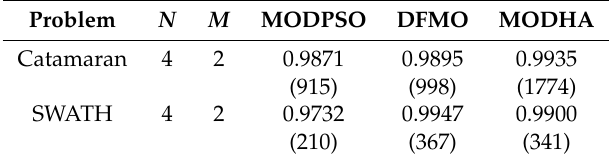
Figure 10. SBDO problems: Comparison of the non-dominated solution sets obtained (from left to right) by MODPSO, DFMO, and MODHA with the most promising parameters setup. Table 3. SBDO problems, summary of the optimization results in terms of NHV